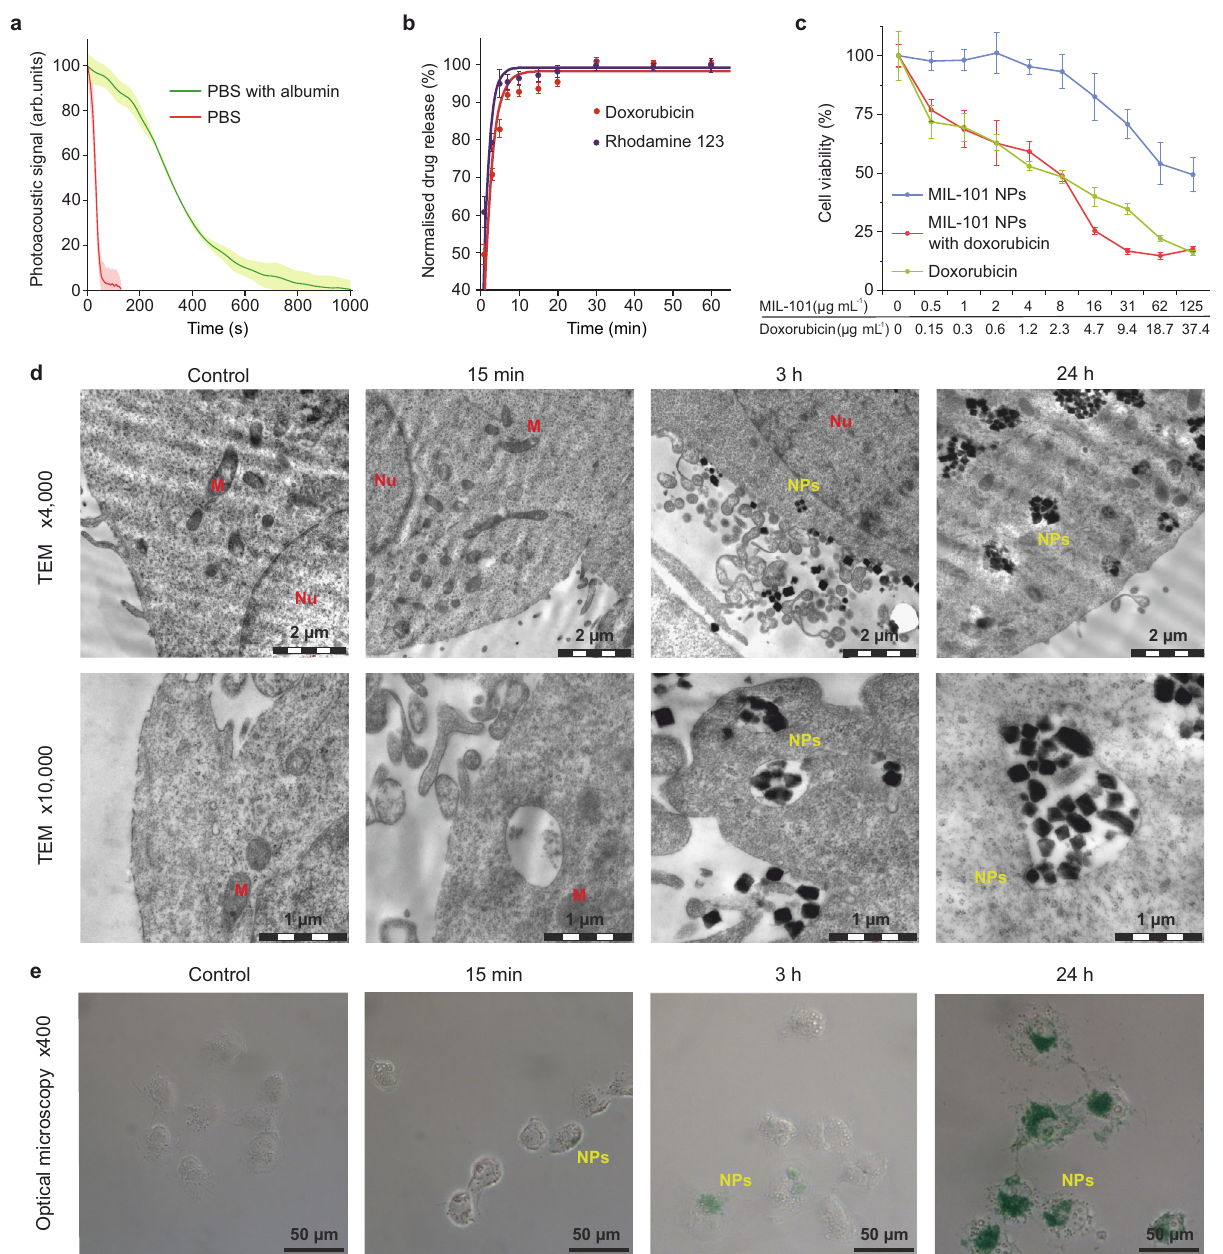
Fig. 4 | The MIL-101 nanoparticles interaction with cells in vitro. a The MIL-101 nanoparticle (NP) degradation kinetics in PBS (red) and PBS supplemented with 50gL − 1 of albumin (green), n =3samples. b The normalised release kinetics curves for rhodamine 123 (purple) and doxorubicin (red) from the MIL-101 NPs in serum. n =3 samples. c MTT cytotoxicity assay of MIL-101 NPs (blue), doxorubicin-loaded MIL-101 NPs (red) and free doxorubicin (green) with NCI-H1299 cells. The cell via- bility is presented as % ratio normalised to the non-treated control cells, n =5 samples analysed per data point. d Representative images of the MIL-101 NP uptake by NCI-H1299 cells 15min, 3h and 24h post incubation. Top — transmission